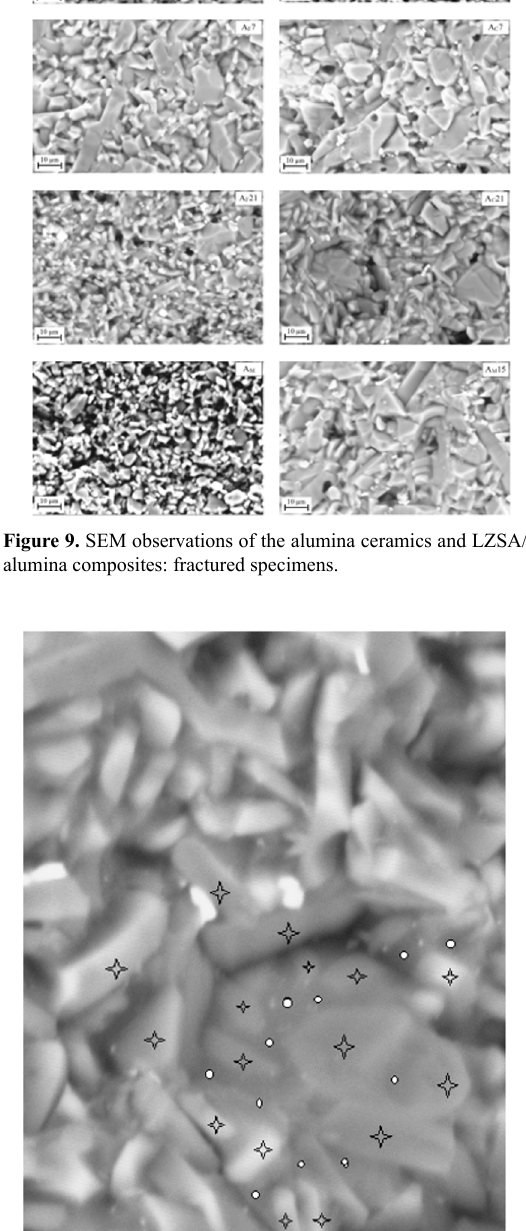
Figure 10. Detail of the fractured composite A ○ LZSA glass-ceramic.